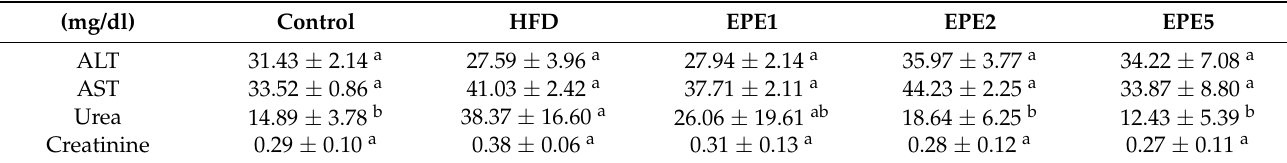
Data are shown as the mean ± S.E.M. ( n = 5). The values with different superscript letters (a,b) are significantly different ( p < 0.05), as determined by one-way ANOVA, and were analyzed by Duncan’s multiple range